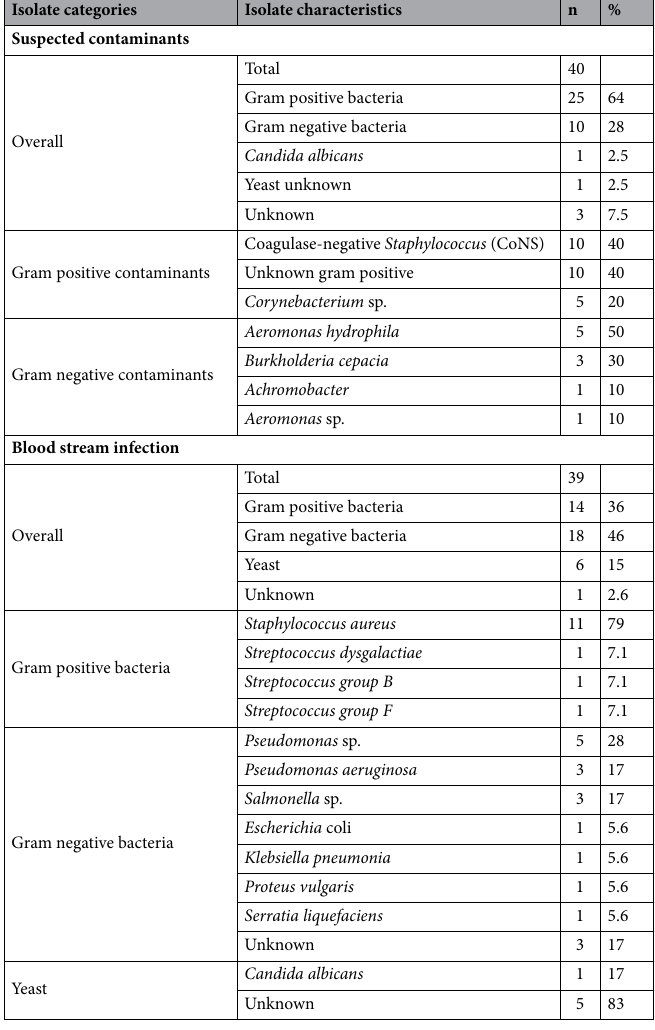
Table 4. Blood culture results for pediatric patients admitted with severe sepsis in AGH, November 2018– August